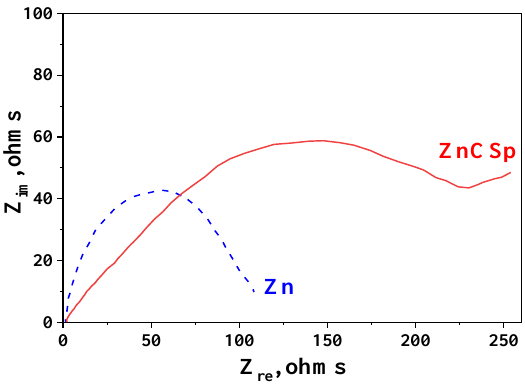
Figure 6. Electrochemical impedance spectroscopy (EIS) measurements of Zn and ZnCSp coatings.